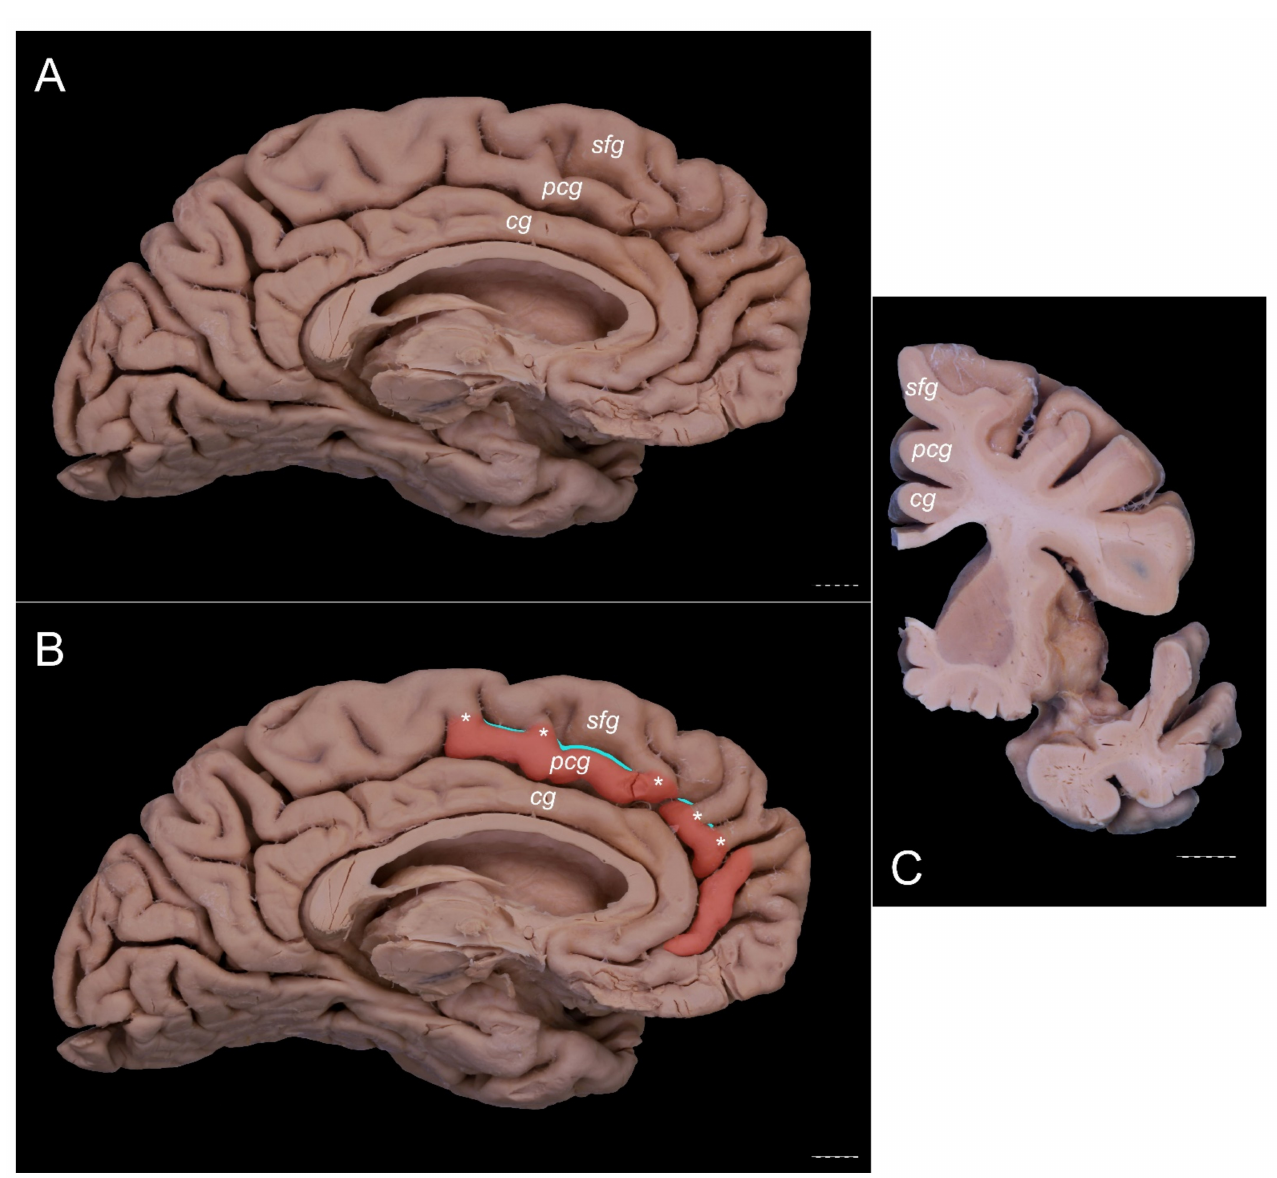
Figure 7. An ambiguous case. Specimens are of the left cerebral hemisphere. The posterior cingulate gyrus should be classified as present based on the length of the PCS < 40 mm. However, the gyrus crosses the level of the VAC line posteriorly. ( A ) A medial view of this specimen. ( B ) A medial view of the same specimen with the PCG colored orange. The VAC and AC-PC lines are marked. The interrupted PCS is marked with teal color. ( C ) Coronal section of this specimen at the level of the VAC line. A separate cingulate, paracingulate, and superior frontal gyri are marked. cg—cingulate gyrus; pcg—paracingulate gyrus; sfg—superior frontal gyrus. Scale bar corresponds to 10